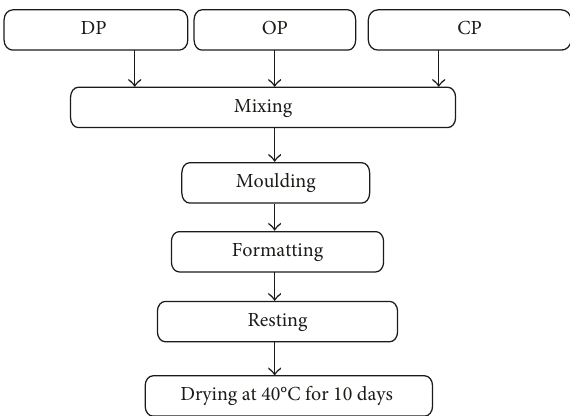
Figure 1: Diagram of preparation of candies. DP: date fruit paste; OP: olive fruit paste; CP: carob fruit powder. Table 1: Design